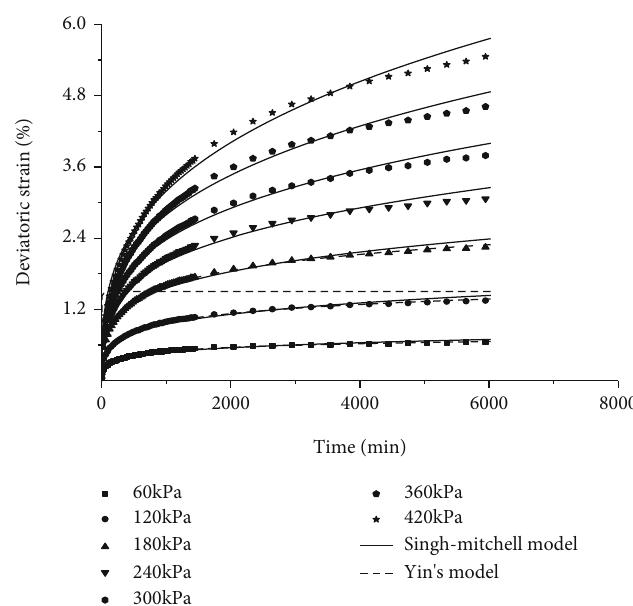
Figure 11: Fitting curves of intact soil by the Singh-Mitchell model and Yin ’ s model.